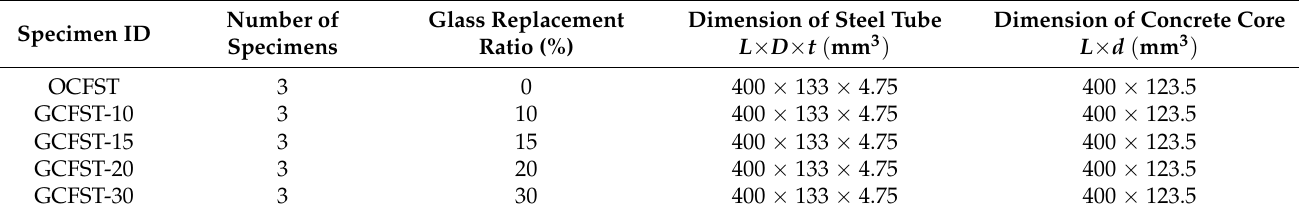
Table 2. Details of column